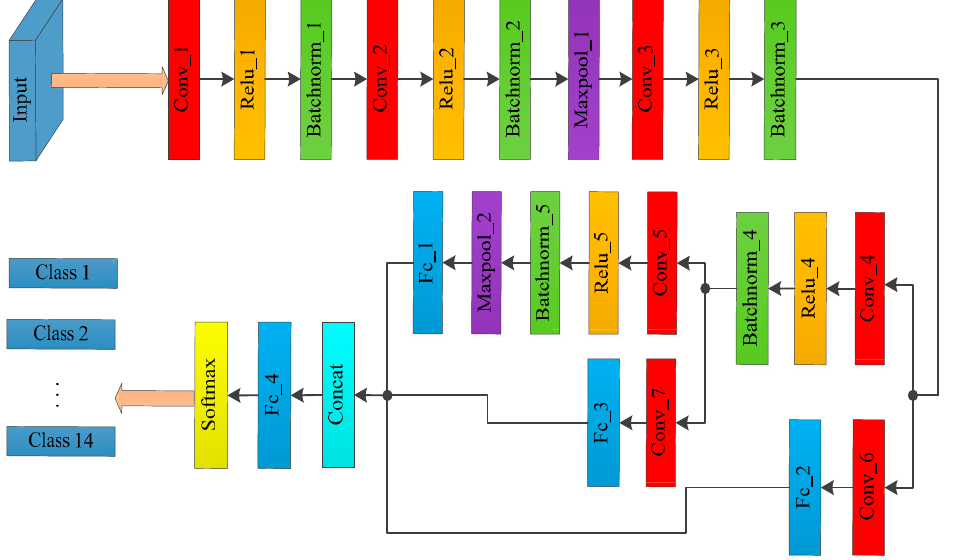
Figure 3. MSCDN classifier architecture.